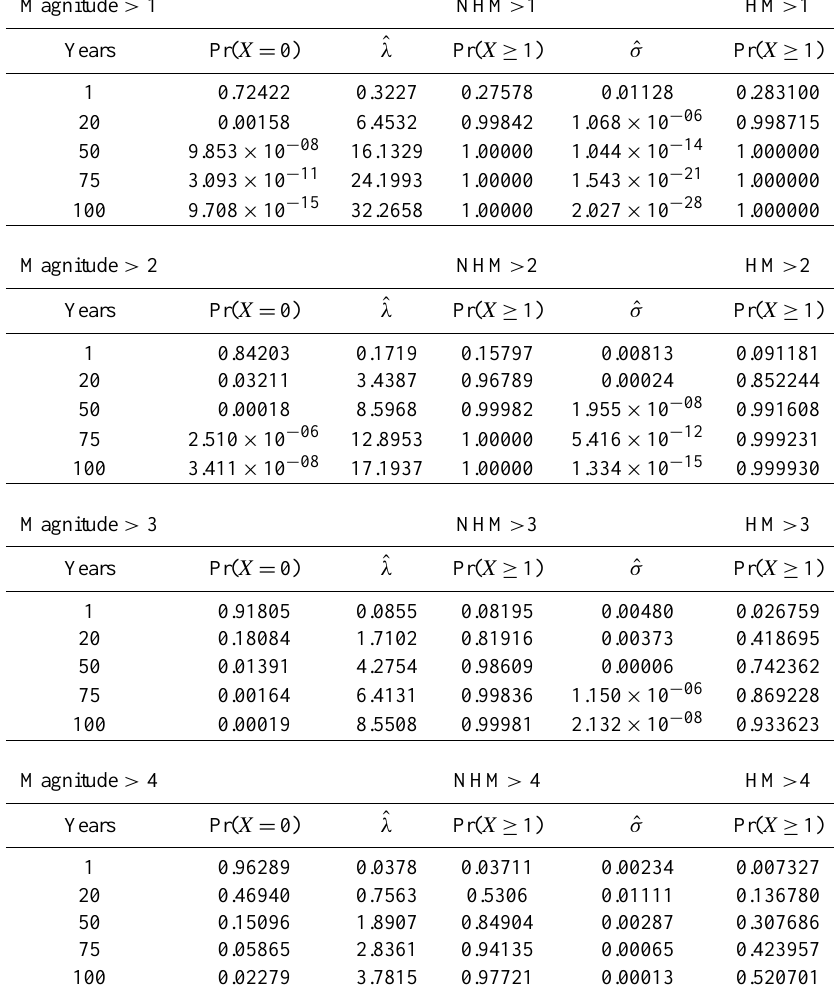
Table 4. Probability of at least one event of Magnitude M >x in the next t years in the Canary Islands estimated with a NHGPPP. (Pr( X = 0) and Pr( X ≥ 1) are the probability of having no eruption and the probability of having at least one eruption, respectively, of a certain magnitude in a particular time interval; NHM and HM are the probability estimated with the NHGPPP and the Homogeneous Poisson, respectively, for magnitude M ; ˆ λ is the estimated parameter rate for the NHGPPP and ˆ σ is the estimated standard deviation for the Pr( X ≥ 1) computed with the NHGPPP, based on the Delta